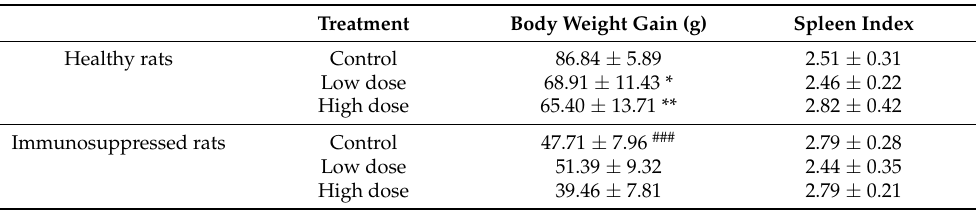
Table 3. Effect of HCFP on body weight and immune organ after 14-repeated day administration in healthy and immunosuppressed Wistar